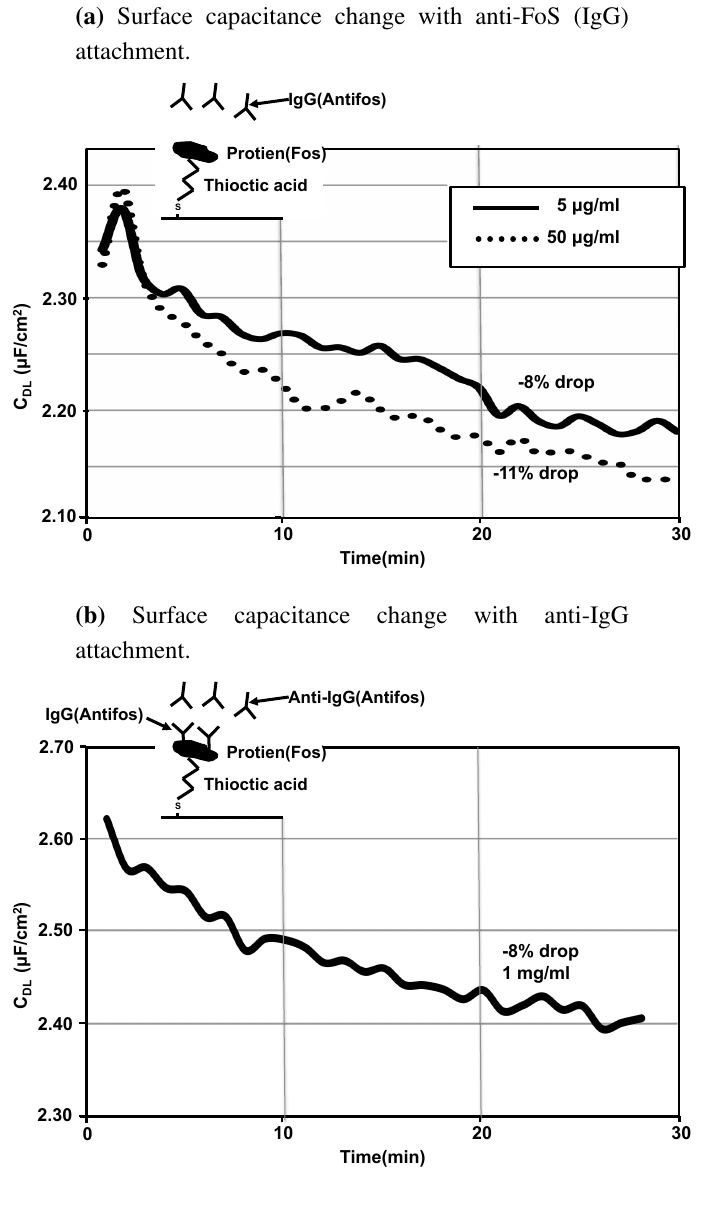
Figure 11. Real-time EIS study is done with addition of 5 µg solution onto a slide that has FoS immobilized on it ( a ) and later with the addition of 1 mg anti-IgG solution ( b